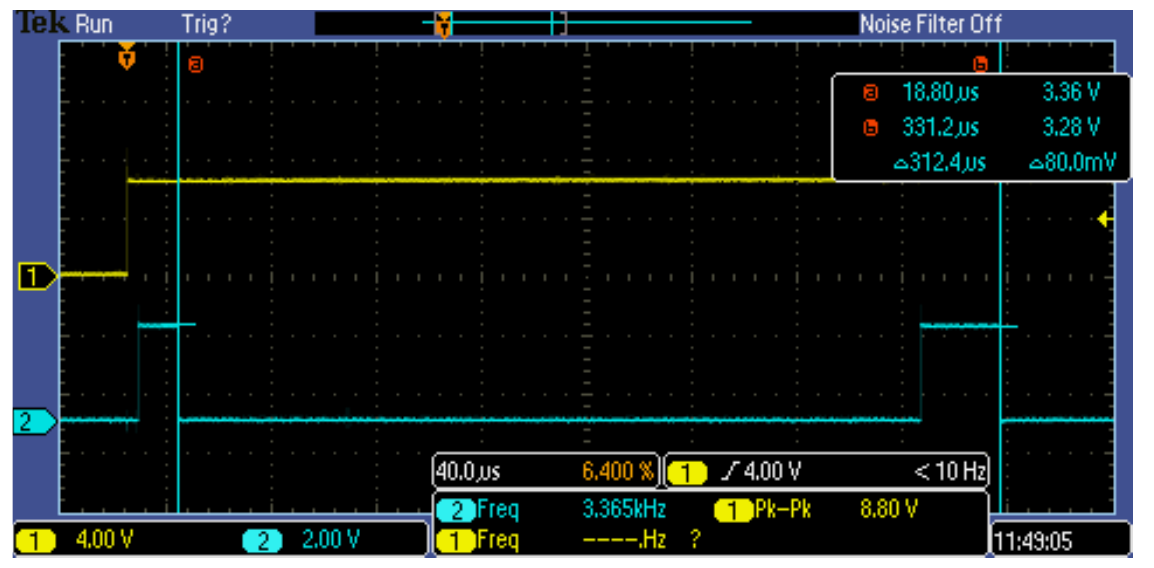
Figure 24. Oscilloscope capture of 3.2 kHz rising edge timing after PPS signal.